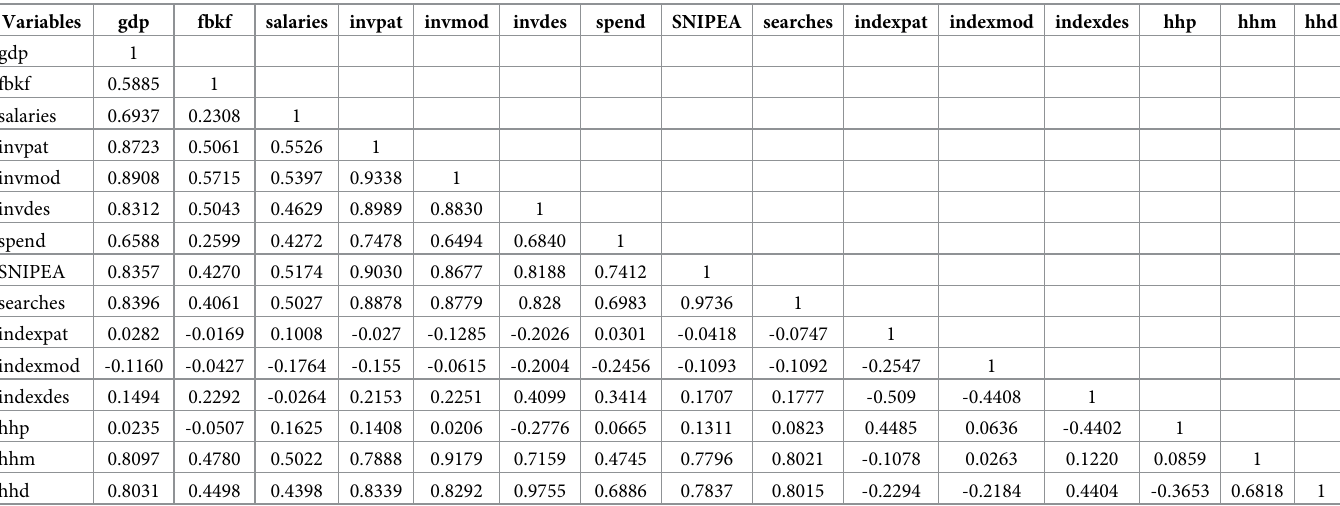
Table 2. Matrix of correlations of the